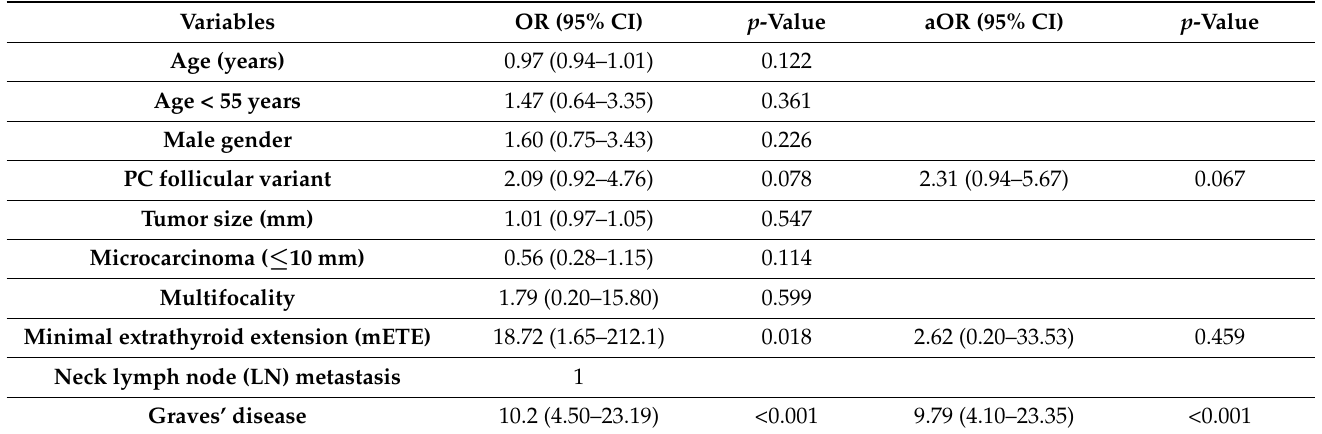
Table 4. The multivariate logistic regression shows that PC/GD patients had a 10-fold higher risk of developing metastasis than PC patients without GD ( p < 0.001). The multivariate analysis includes independent variables resulting with a p < 0.10 in the univariate analysis.